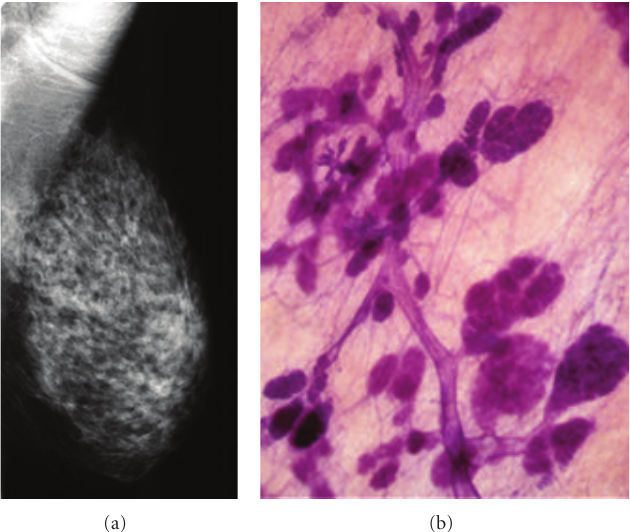
Figure 3: Mammogram of the left breast in the mediolateral oblique projection (a) and large section, subgross (3D) histology of normal breast tissue. (b) On the mammogram the nodular/oval shaped densities (TDLUs) and the linear densities (larger milk ducts) are surrounded by radiolucent adipose tissue, making it possible to account for each nodular and linear density. The nodular densities are the radiologic images of the lobules of varying sizes, and the linear densities are ducts as seen on the 3D